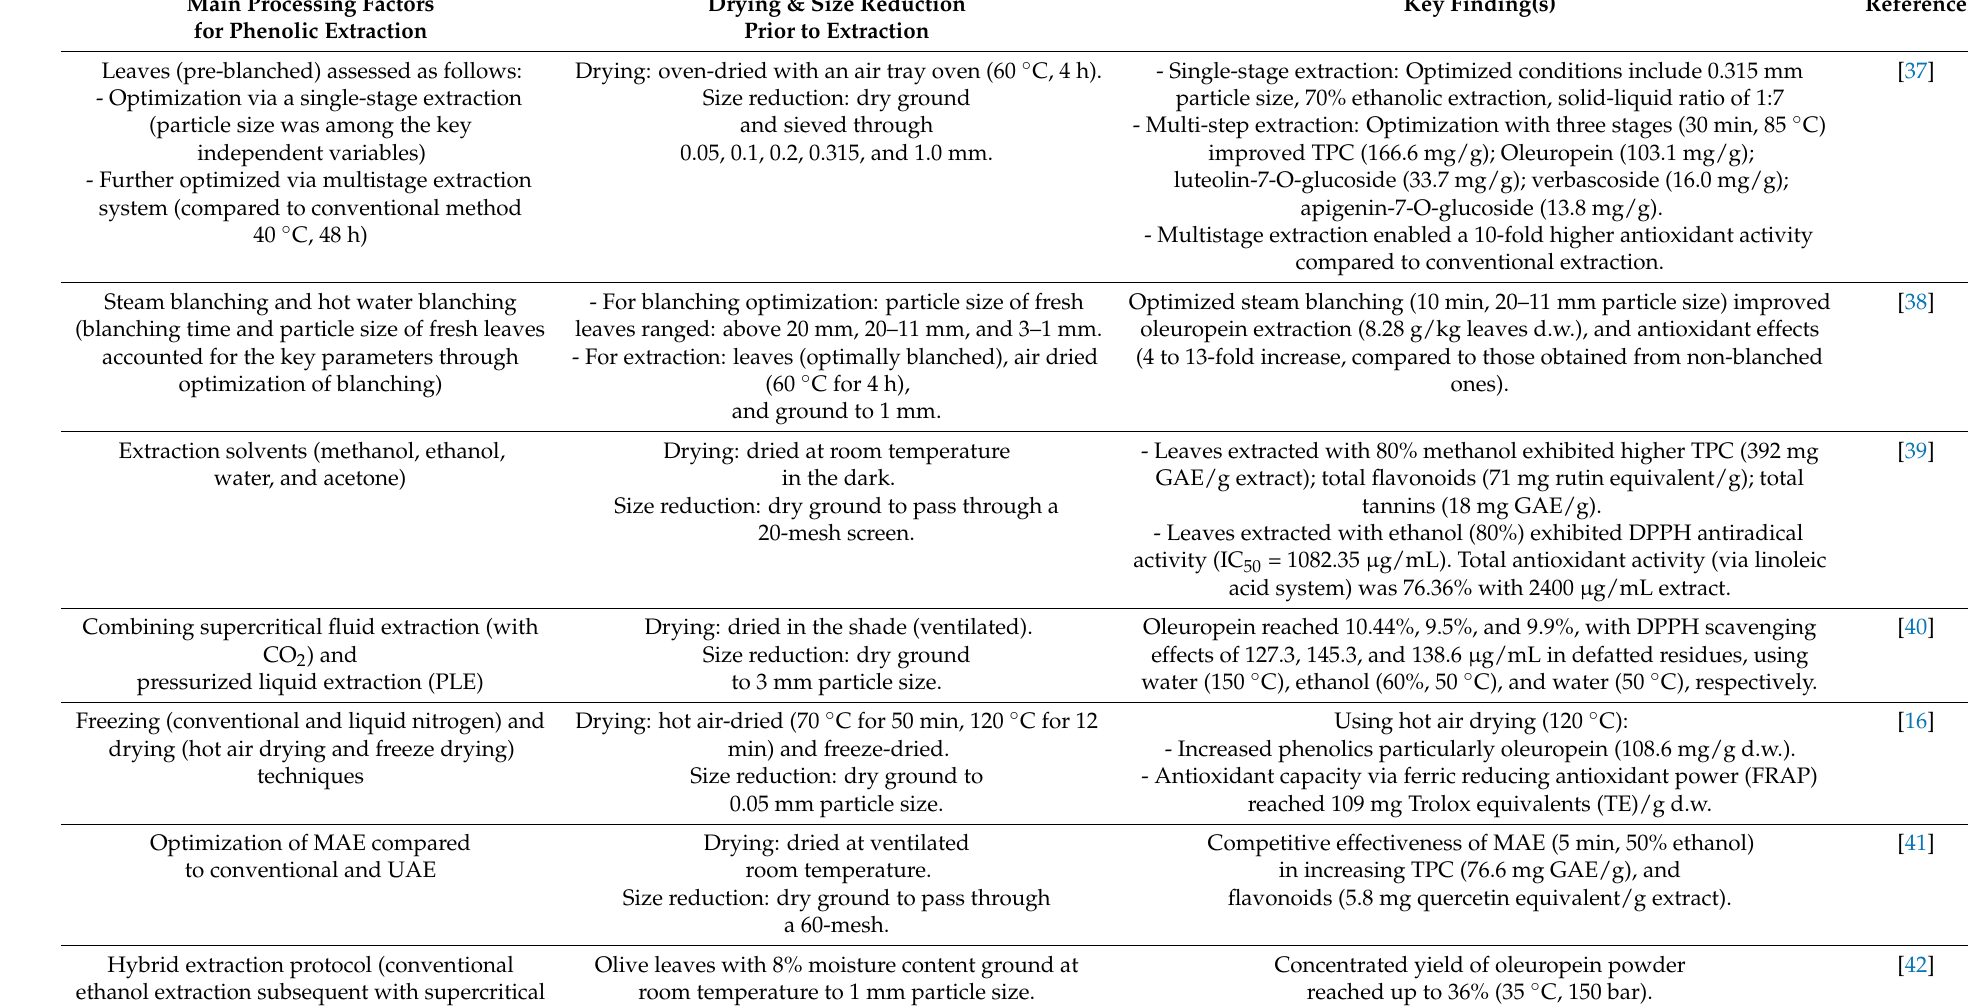
Table 1. Examples of drying and size reduction approaches used prior to phenolic extraction of olive